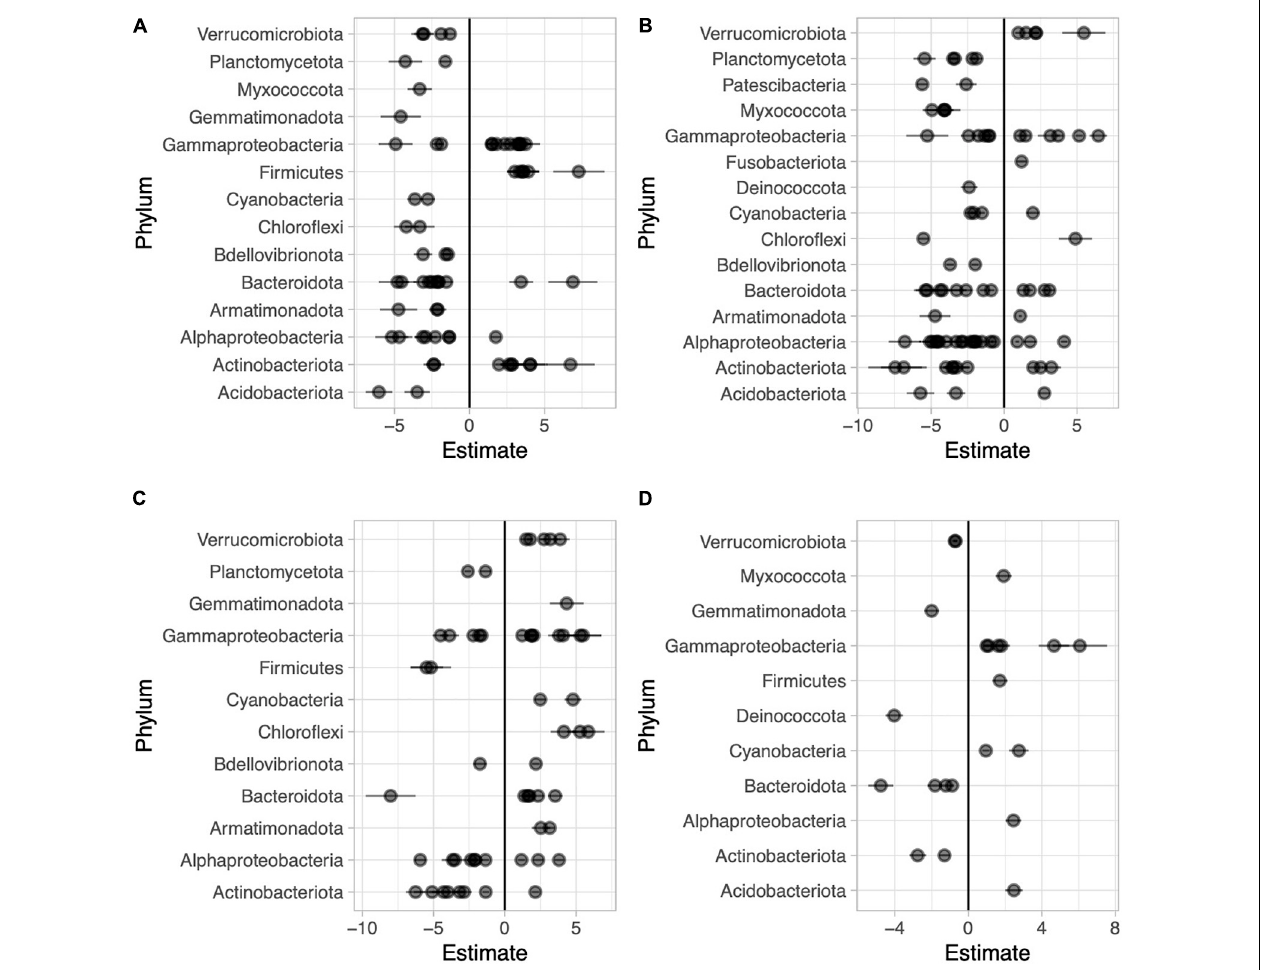
FIGURE 6 | Beta coefficient estimates from the corncob regression model for differentially abundant families for each pairwise comparison between sample types in Long Lake: Abaxial (bottom) vs. adaxial (top) leaf surfaces, where negative beta estimates indicate taxa more abundant on the bottom while positive estimates indicate taxa more abundant top (A) , abaxial leaf surface vs. water, where negative beta estimates indicate taxa more abundant on the bottoms of leaves while positive estimates indicate taxa more abundant in the water (B) , adaxial leaf surface vs. water where negative beta estimates indicate taxa more abundant on the tops of leaves while positive estimates indicate taxa more abundant on adaxial surfaces (C) , and high vs. low in the water column across all samples where negative beta estimates indicate taxa more abundant on the surface and positive estimates indicate taxa more abundant lower in the water column (D) . Individual families are represented by points and are grouped by